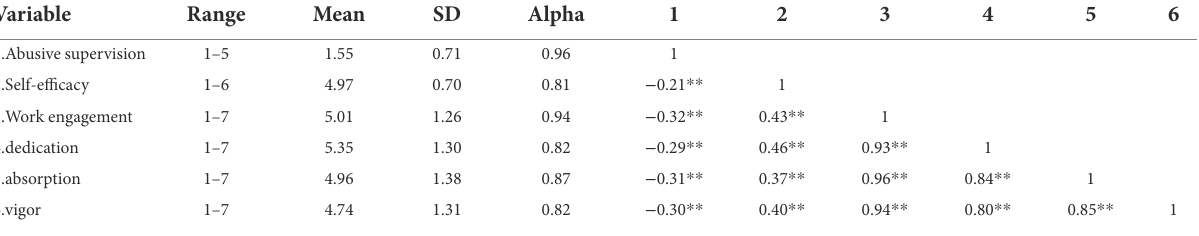
TABLE 2 The means, standard deviations, alpha reliabilities and correlations for the study variables.